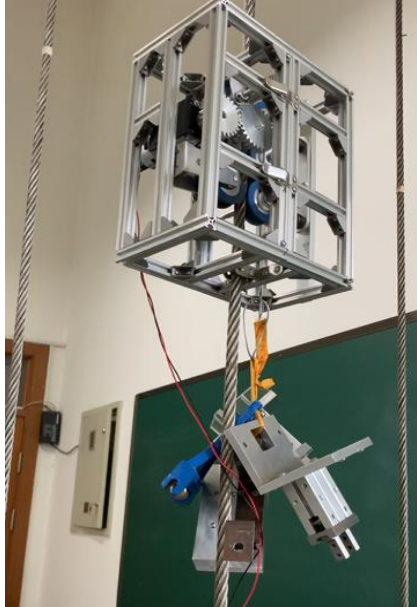
Figure 13. Load capacity test setup.